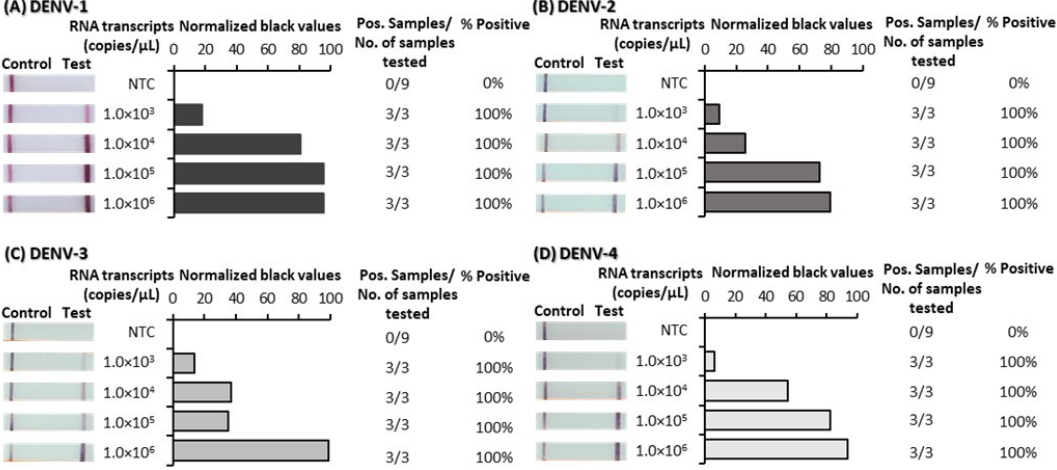
Figure 2. Analytical sensitivity determination of dengue virus (DENV) 1–4 reverse-transcription recombinase polymerase amplification lateral flow detection (RT-RPA/LFD) tests using in vitro transcribed RNA. Sensitivity testing used non-structural 5 (NS5) gene fragment RNA transcripts diluted 10-fold in water for DENV-1 RT-RPA/LFD ( A ), DENV-2 RT-RPA/LFD ( B ), DENV-3 RT-RPA/LFD ( C ) and DENV-4 RT-RPA/LFD ( D ). Images of lateral flow strips (LFS) with two bands (control and test band) indicates the sample is positive for respective DENV RNA transcript, and single control band indicates a valid reaction with negative sample. Photograph of lateral flow strips with control bands (all samples) and test bands (positive samples) compared to copy number of serially diluted template RNA (copies/μL) and no template control (NTC) (left). Normalised pixel density (normalised black values) from the lateral flow test strip displayed (middle). Positive (Pos.) samples compared to number (No.) of samples tested at that dilution was used to calculate the percentage of positive tests performed at that dilution